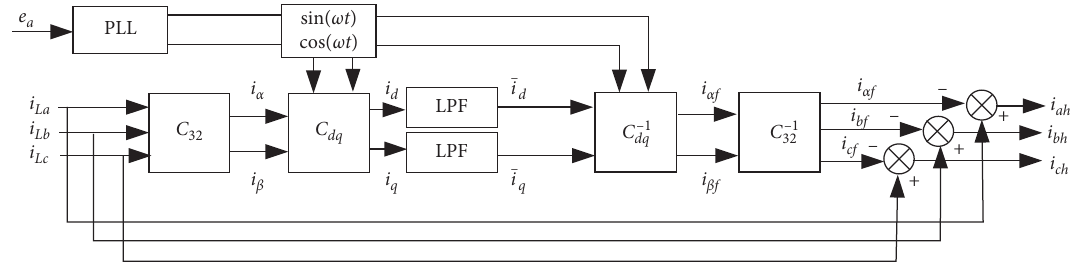
Figure 3: i p - i q method for harmonic detection of the reference